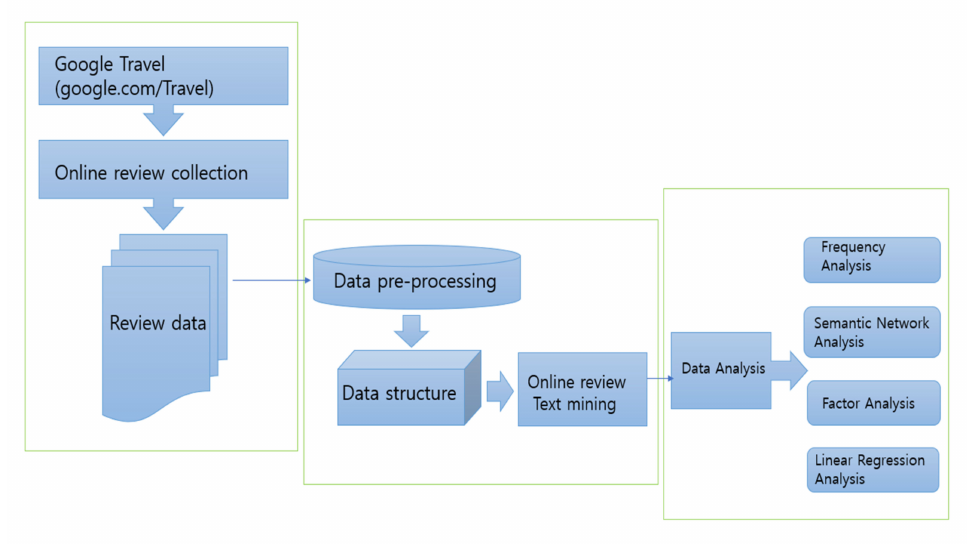
Figure 2. Research